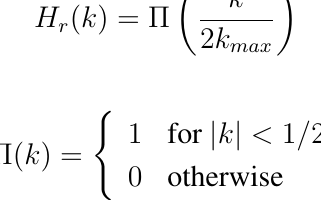
( k ) represents r ( k ) represents the d ( k ) represents the outer o